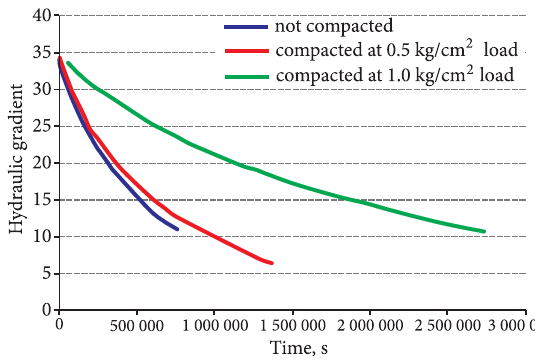
Fig. 4. Dependence on the hydraulic gradient and the filtration time of natural structure clay